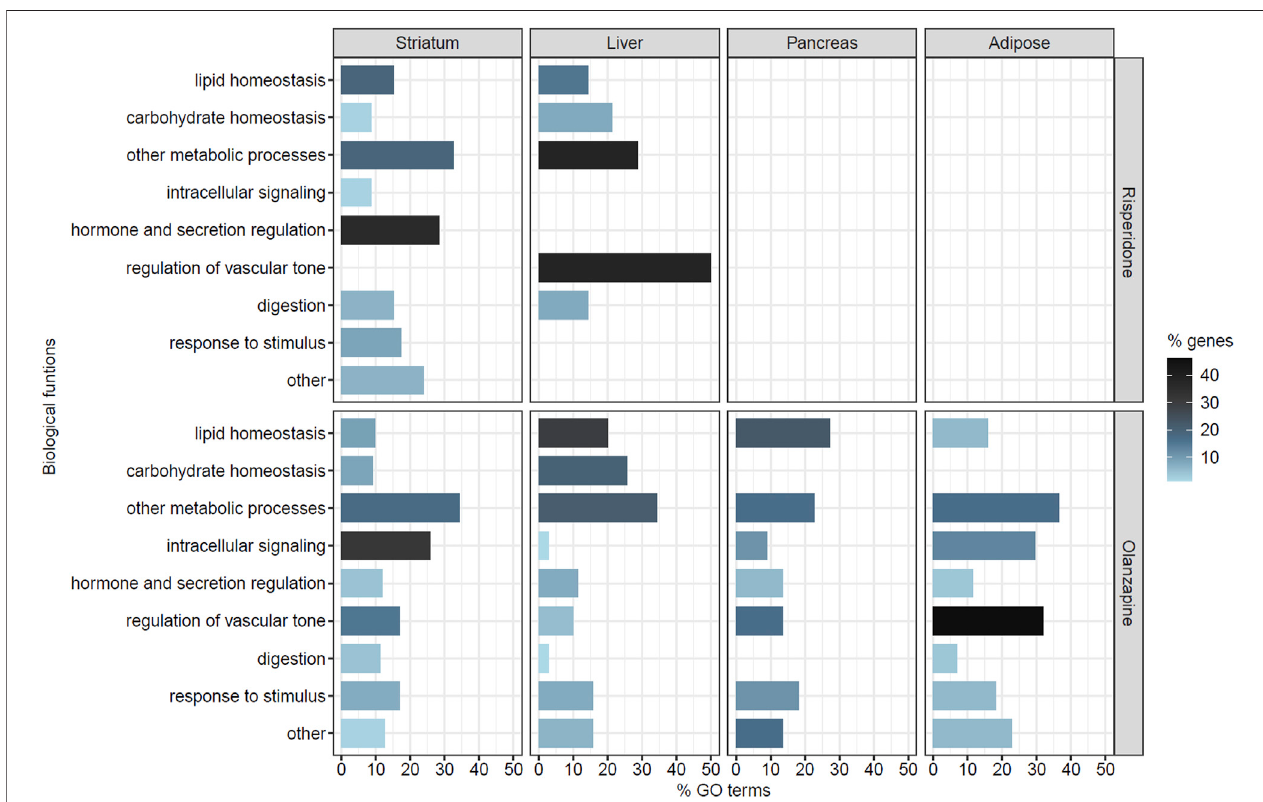
FIGURE 2 | Selected biological processes related to metabolic dysregulation in each tissue of risperidone- or olanzapine-treated mice. The Y-axis represents the different categories of biological functions considered. The X-axis represents the percentage of processes (% GO terms) related to each biological function out of all the selectedGOtermsineachtissueforeachantipsychotic.Thecolorgradientrepresentsthepercentageofgenes(%genes)relatedtoeachbiologicalfunctionoutofallthe genes included in the selected GO terms in each tissue for each antipsychotic. No signi fi cant gene modules were identi fi ed in the adipose tissue of risperidone- treated mice. None of the signi fi cant GO terms identi fi ed in the pancreas of the risperidone-treated mice were related to metabolic dysregulation.